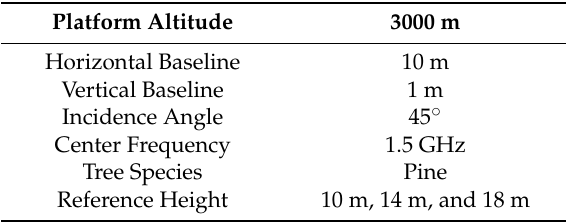
Table 1. Main parameters of the simulated data of forest with PolSARpro Forest Simulator. Three datasets with reference height of 10 m, 14 m, and 18 m were